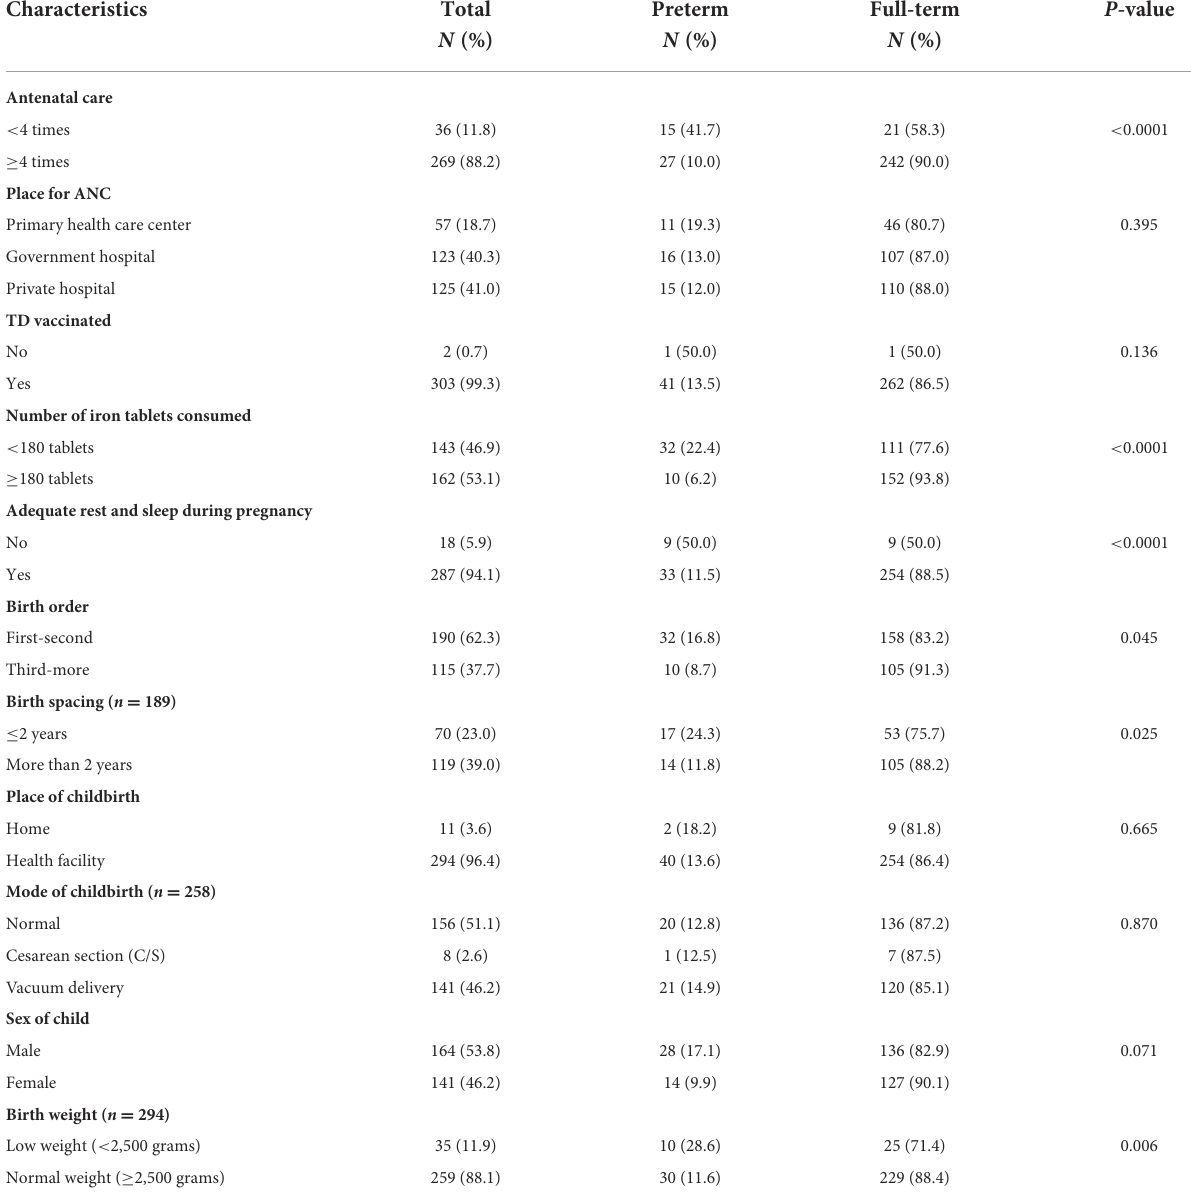
TABLE 3 Antenatal, natal and postnatal care characteristics, maternal obstetric history, and newborn characteristics associated with PTB.